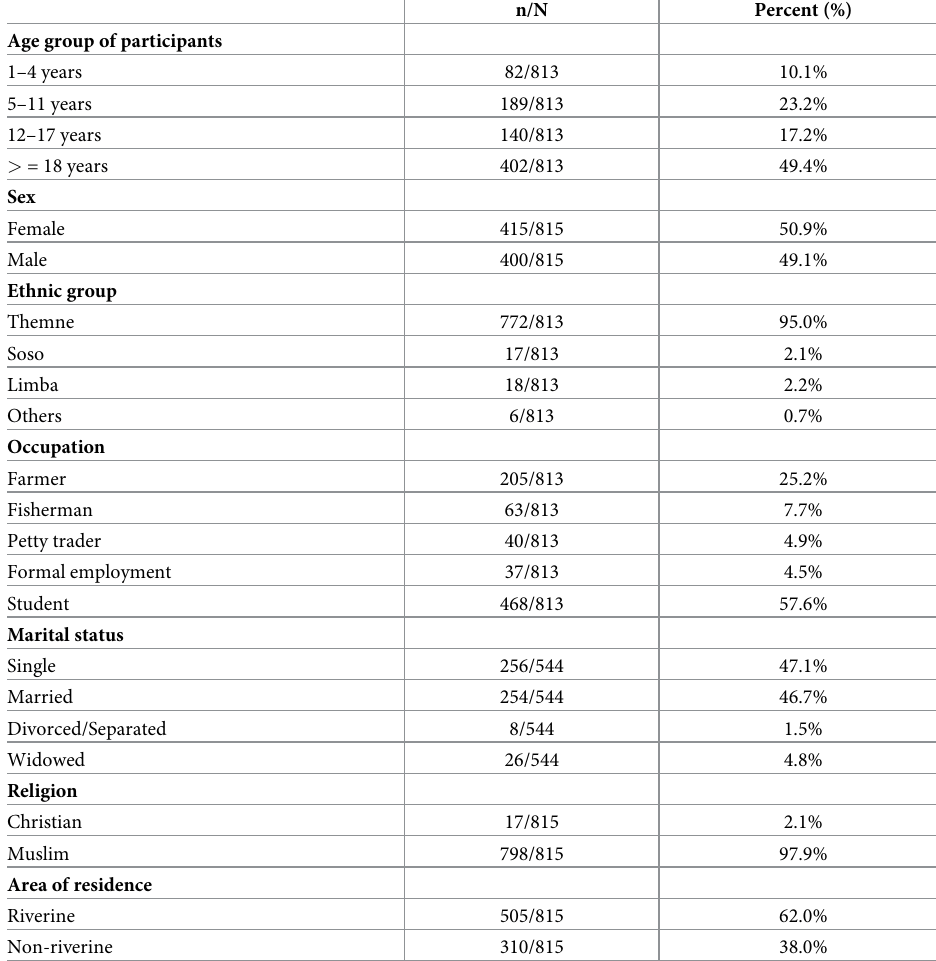
Table 1. Characteristics of participants in the parasitology survey in the Mambolo